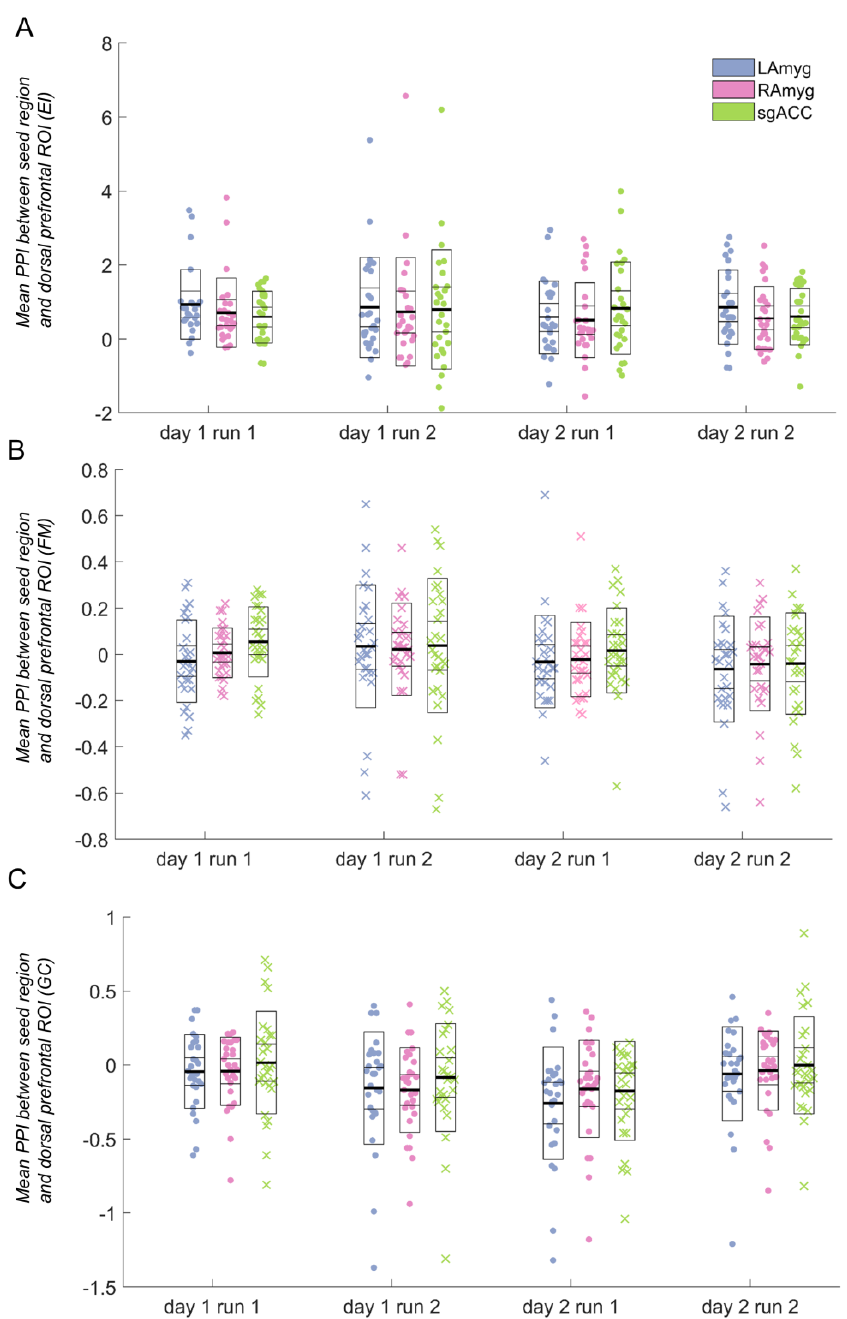
Figure 2. Psychophysiological interaction (PPI) parameter estimates for each task between the seed regions and the dorsomedial frontal / cingulate (DMFC) cortex region of interest. Data marked with “x” (as opposed to those marked with a filled circle) indicate runs that were not significantly di ff erent from zero (and therefore were not analysed further). Horizontal lines in the box plots indicate the mean (darkest line), standard deviation, and 95% confidence interval. A: Emotion identification (EI) task; B: Face matching (FM) task (not analysed further, as the average PPI parameter estimates were not significantly di ff erent from zero); C: Gender classification (GC) task (the subgenual anterior cingulate cortex (sgACC) seed was not analysed further, as the average PPI parameter estimate was not significantly di ff erent from zero). ROI: region of interest; LAmyg: left amygdala; RAmyg: right